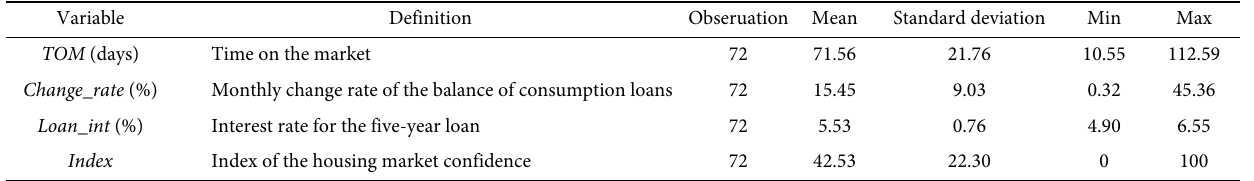
Table 1 Variable definitions and